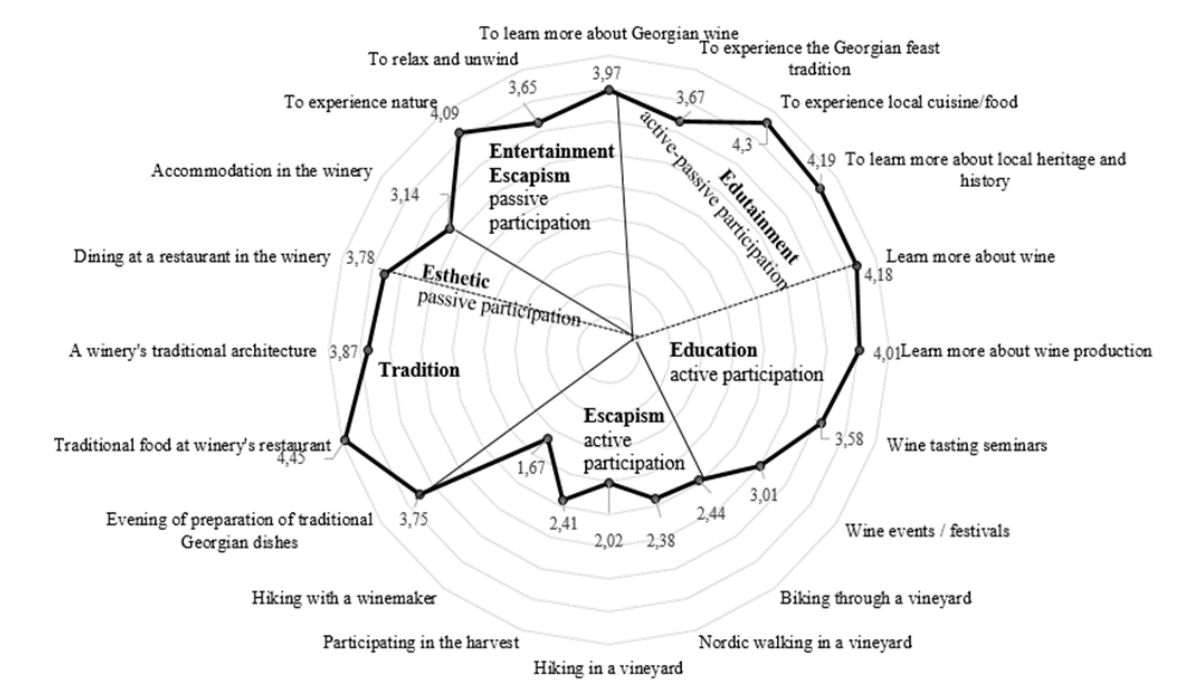
Figure 2. Interrelationships between motivation and expectations among wine tourists.